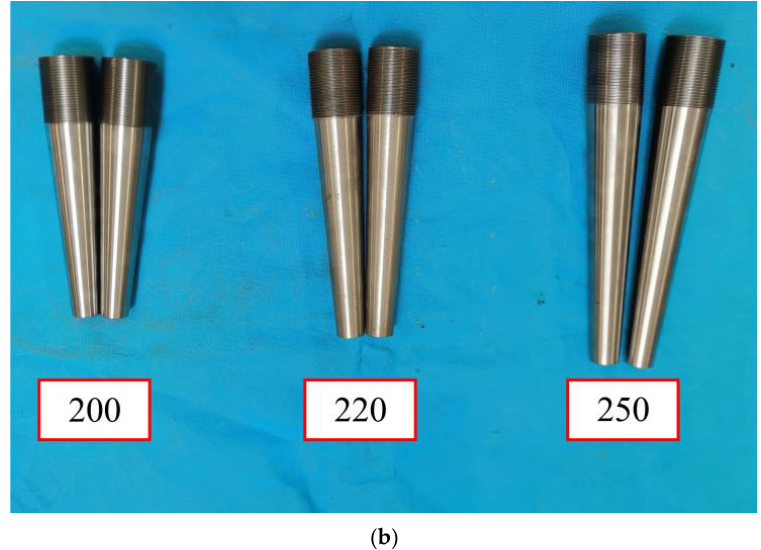
Figure 5. Partial CFRP strand and conical anchors for testing. ( a ) Partial CFRP strand for testing; ( b ) conical anchors for testing.